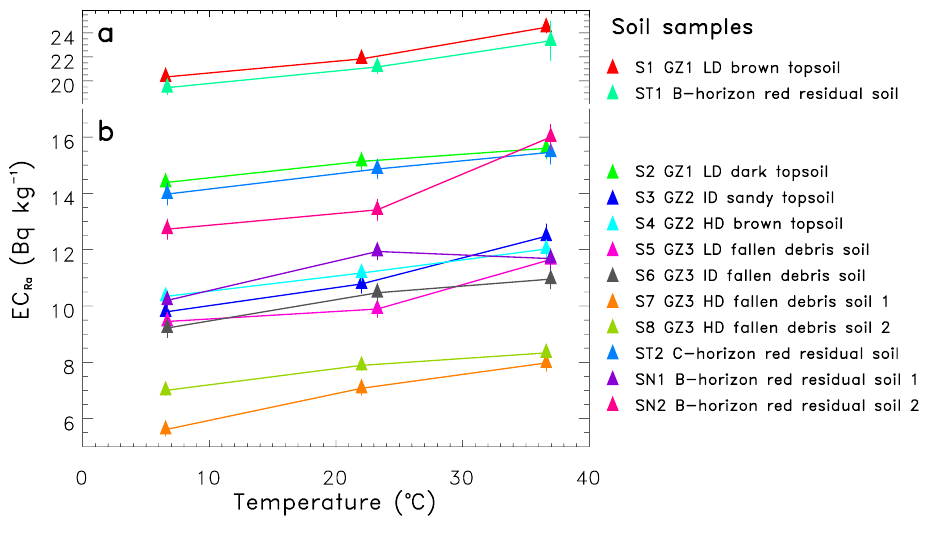
Fig. 4. EC Ra of the twelve soil samples as a function of temperature. S1 and ST1 samples are depicted in (a) , while the ten other soil samples are shown with the same vertical scale in (b)